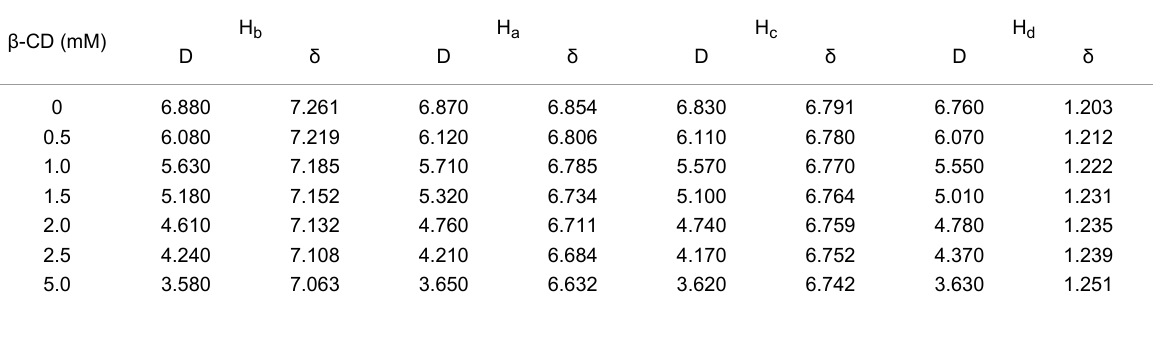
Table 4: Diffusion coefficients ( D , 10 − 10 m 2 /s) and chemical shifts ( δ , ppm) of thymol ( 2 ) protons in the presence of different β -CD concentrations.